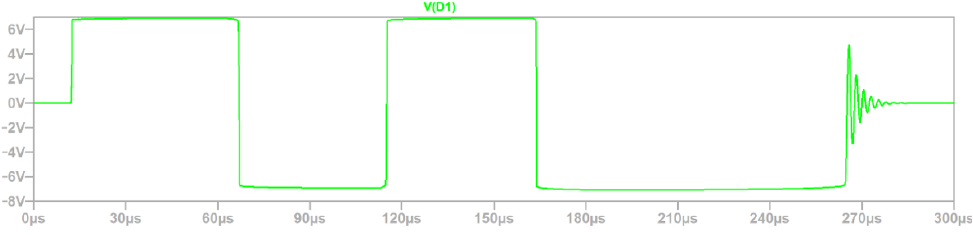
Figure 11. Power and voltages waveforms of R9 and R5.